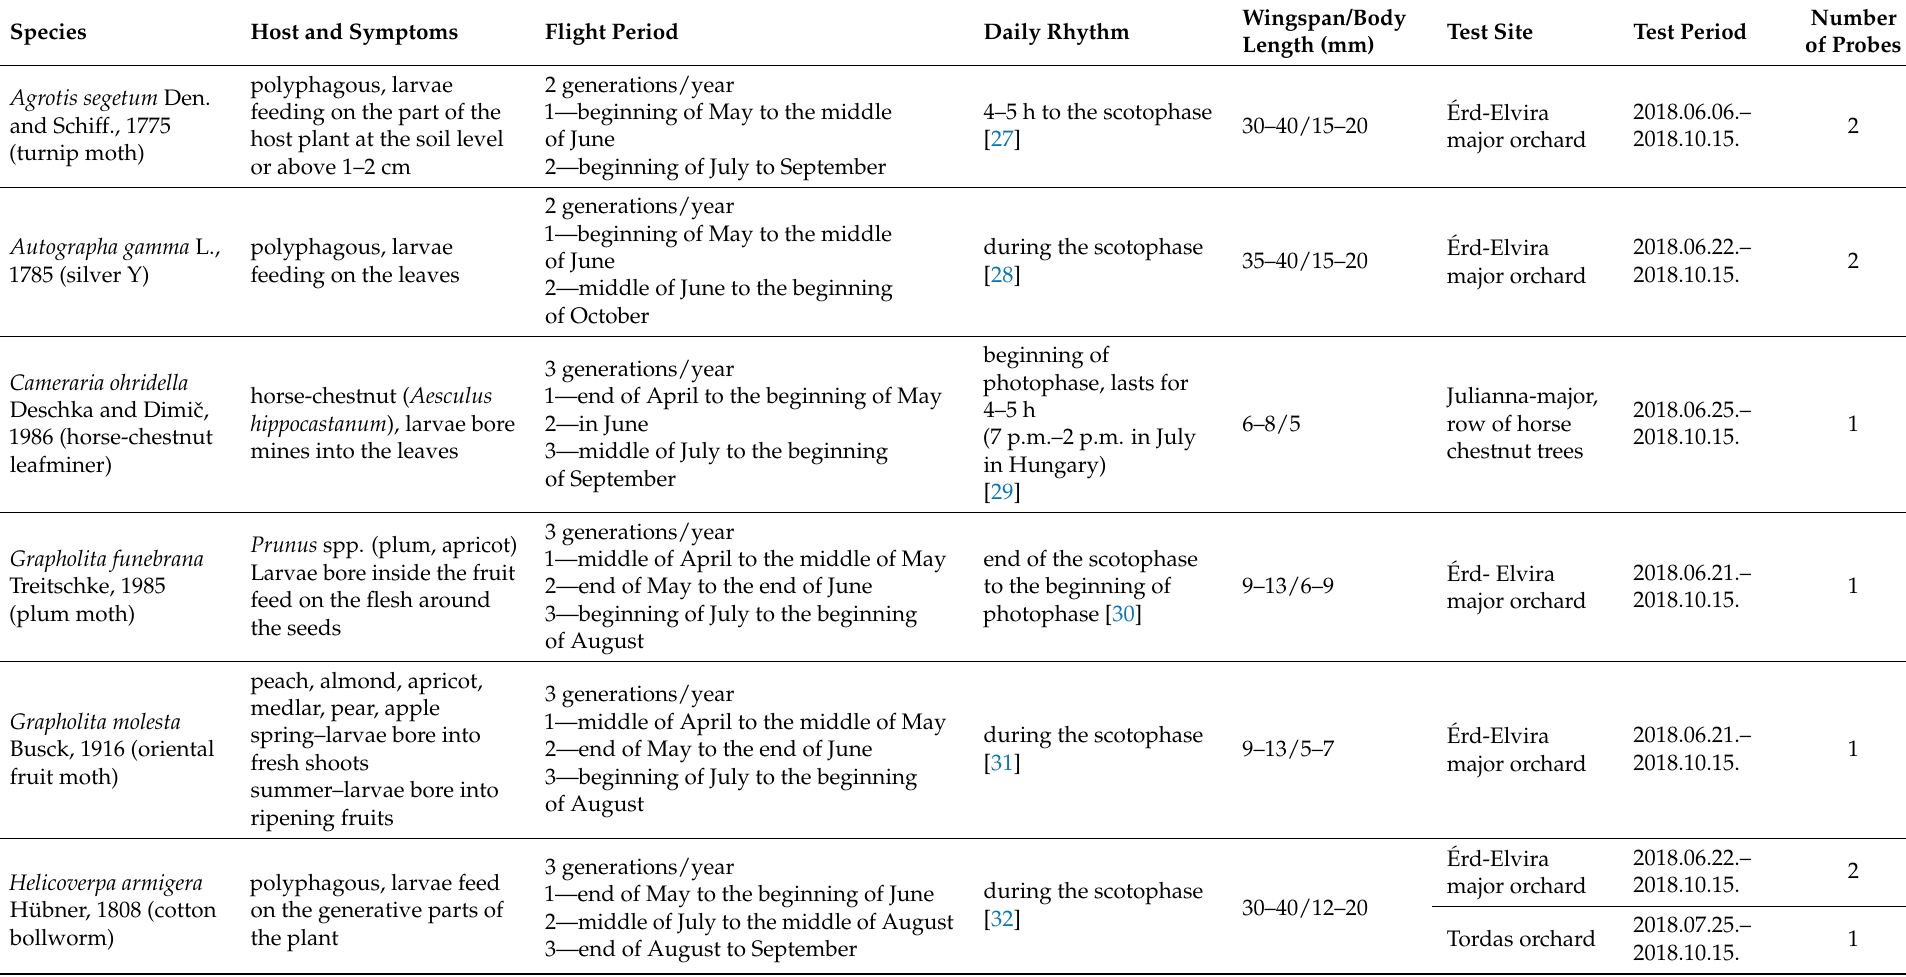
Table 1. Field tests on different